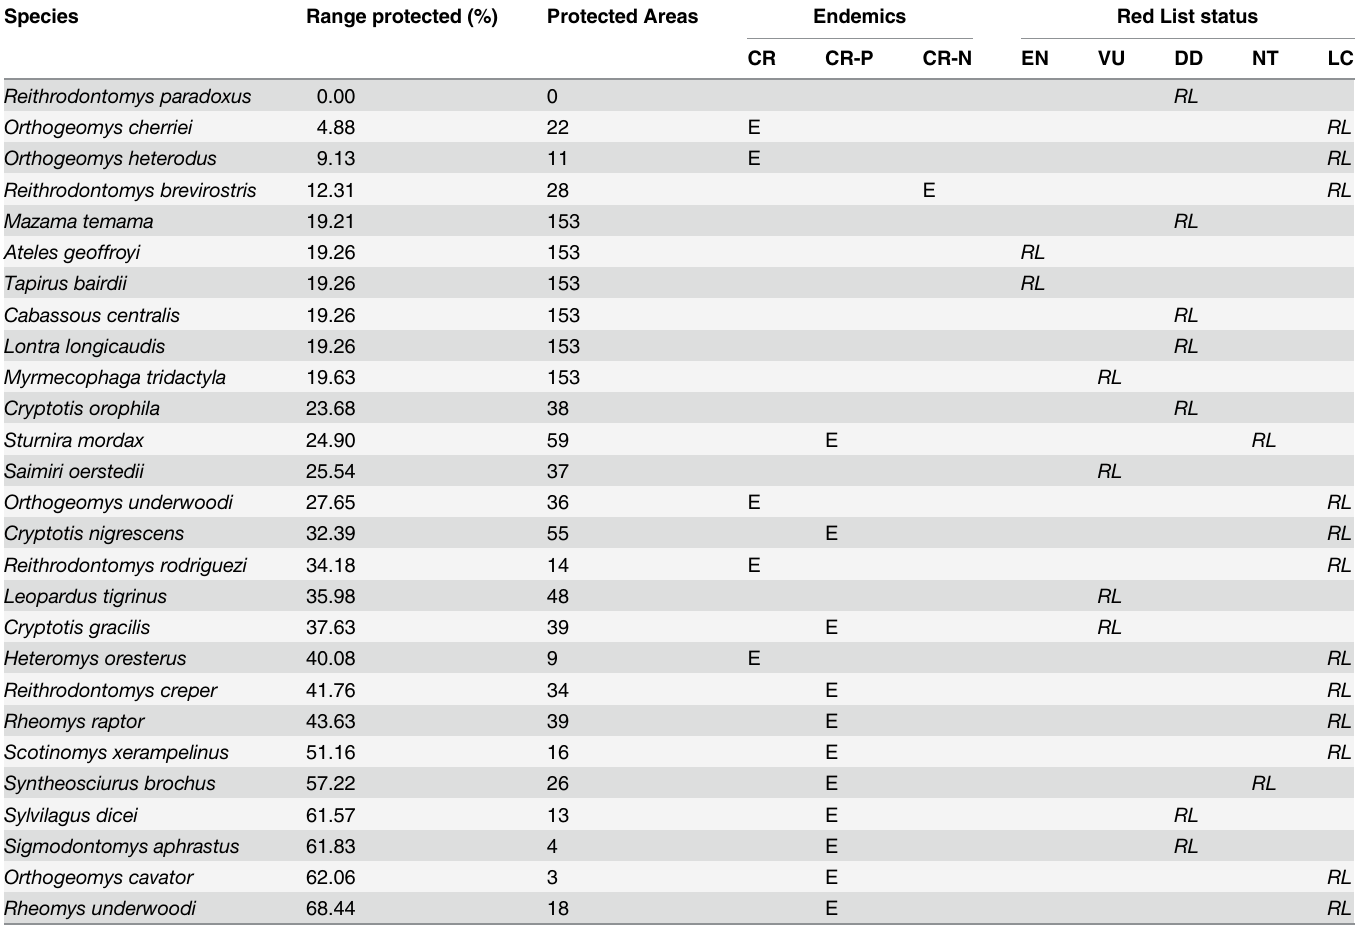
Endemic species to Costa Rica (CR), to Costa Rica-Panama (CR-P) and to Costa Rica-Nicaragua (CR-N) are indicated by E. Species classi fi ed according to the IUCN Red List Criteria [28] as Endangered (EN), Vulnerable (VU), Data De fi cient (DD), Near Threatened (NT) and Least Concern (LC) are indicated by RL (Red